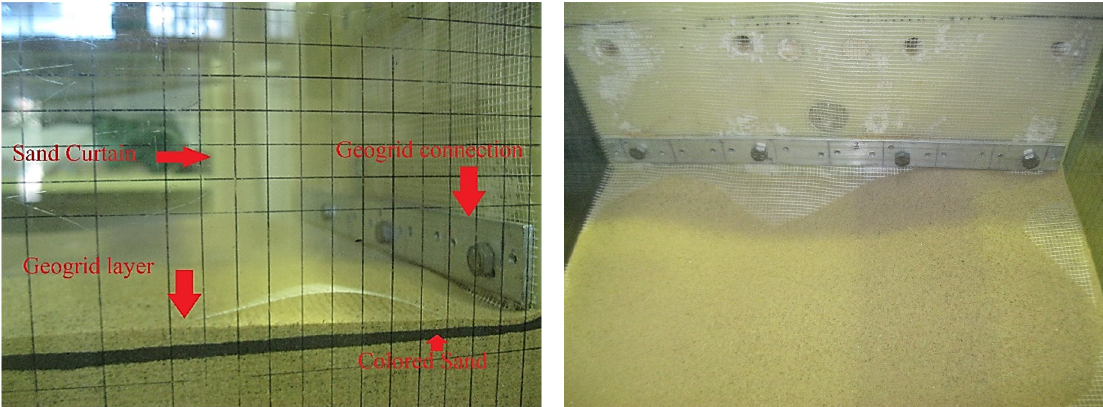
Figure 8. Pluviation and geogrid connection to the wall.